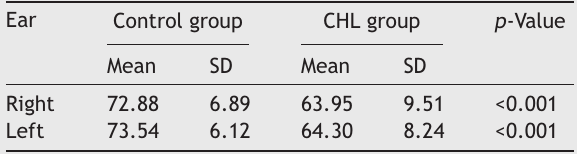
Comparison of the percentage of correct responses (%) between the control and Conductive Hearing Loss (CHL) groups.